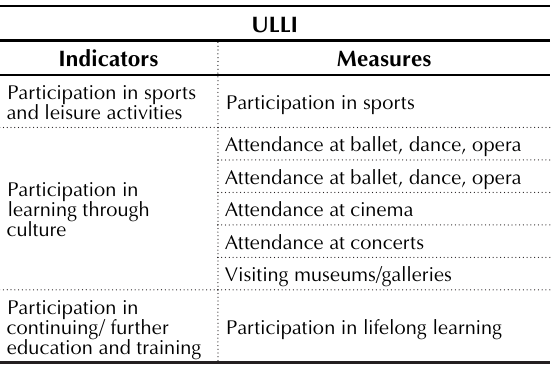
Table 5. The adapted dimension of learning to